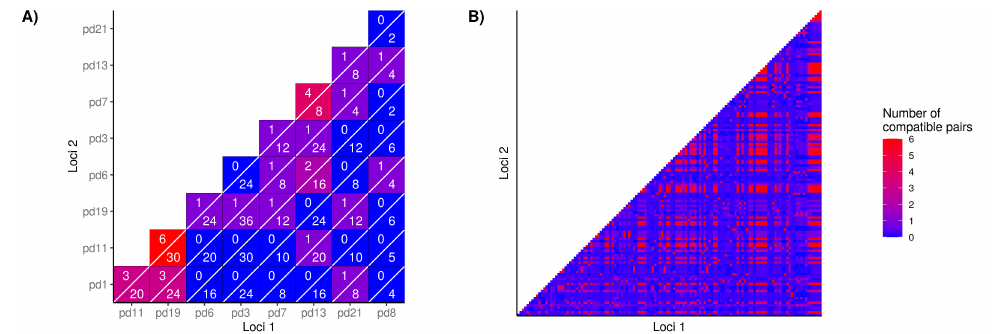
Figure 3. Pairwise comparison of bi-allelic loci where the presence of more than three allele combina- tions results in phylogenetic incompatibility. Within our microsatellite dataset ( A ) the numerator shows the number of pairs that are compatible, while the denominator lists the total number of allelic combinations between the loci. ( B ) SNP loci with greater than 5% of samples missing calls were dropped.